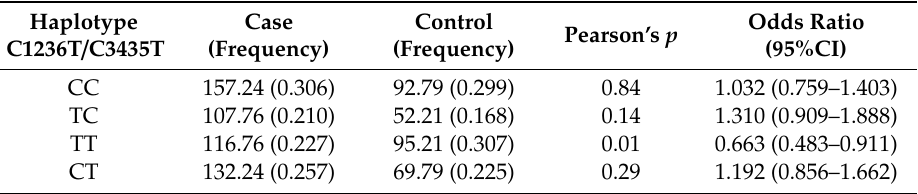
Table 3. Haplotype